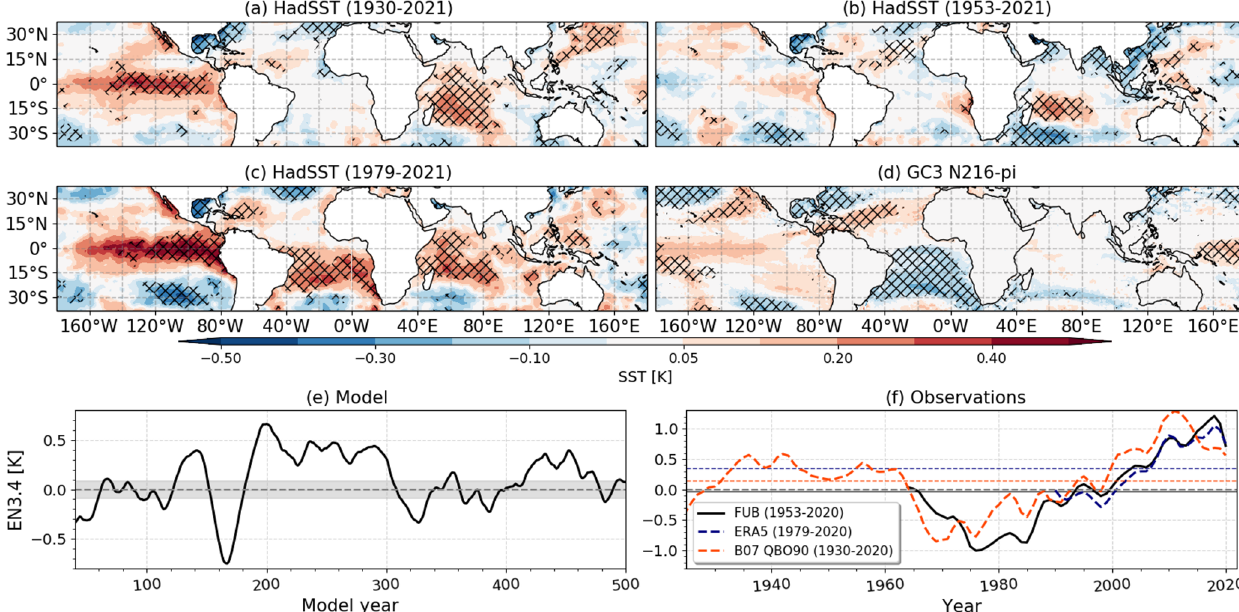
Figure 3. (a–d) SST differences (QBO W–E) in DJF for (a–c) HadSST and (d) GC3 N216-pi. In panels (a) – (c) the HadSST differences are obtained by using (a) the B07 reconstruction (1930–2021), (b) the FUB dataset and (c) ERA5. Panels (e) and (f) show time series of EN3.4 [K] differences (QBO W–E) in (e) GC3 N216-pi and (f) HadSST using the different products for the QBO. In panel (e) the time series are